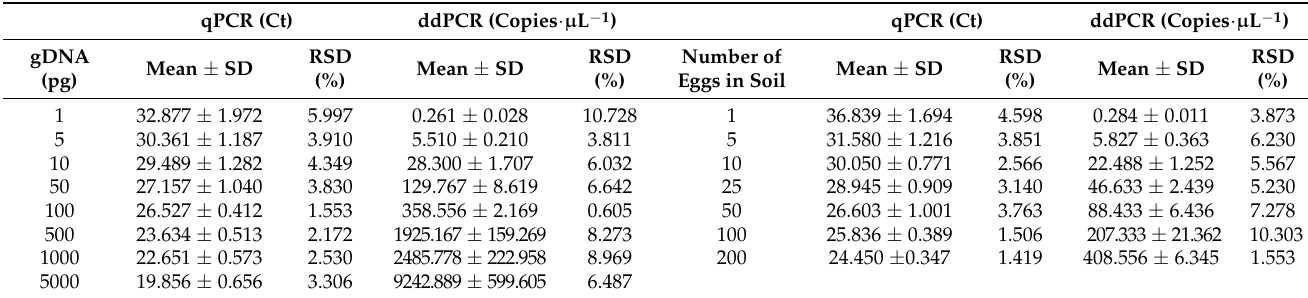
Table 1. The data obtained from qPCR and ddPCR for gDNA dilutions and total DNA templates extracted from eggs in soil.